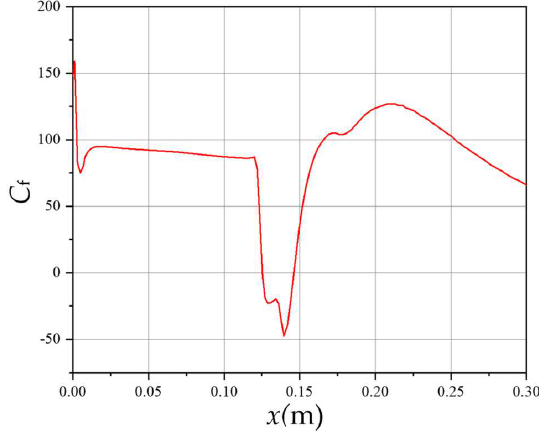
Figure 12. Skin friction coefficient curve of base flow field at z = 0 cross section.